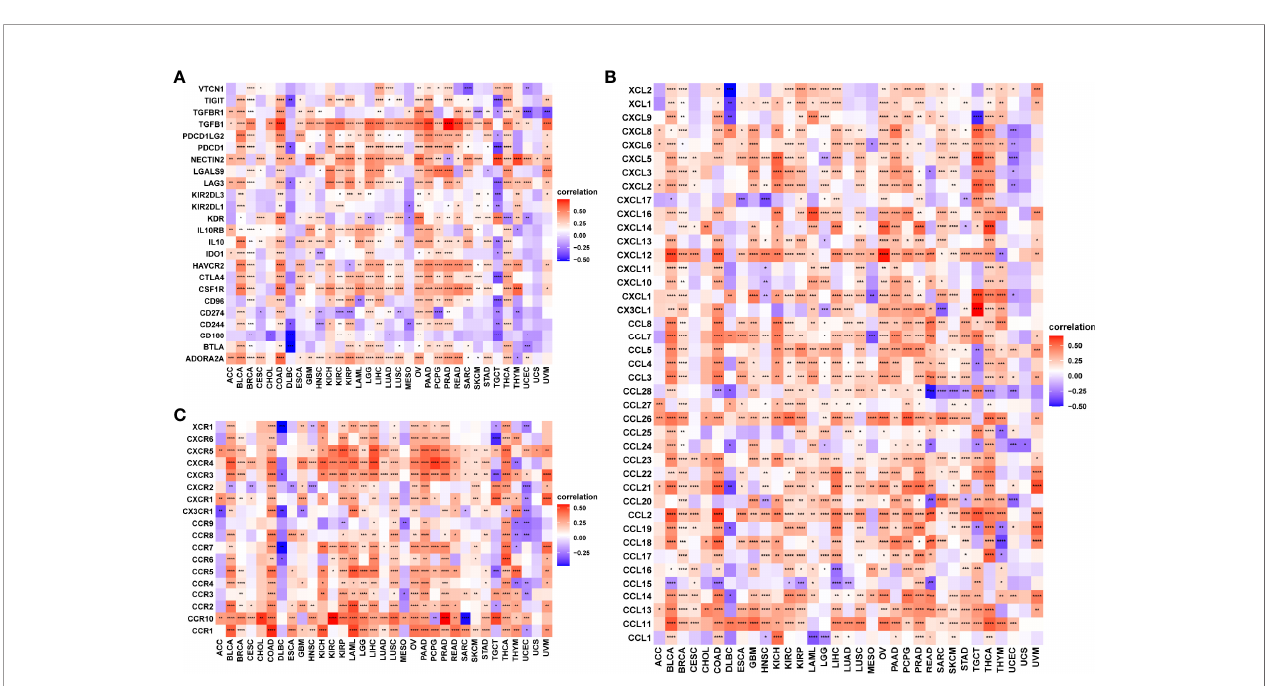
FIGURE 8 | Correlation analysis between RCN3 expression and immuno-related genes. Correlation analysis between RCN3 expression and immunosuppression- related genes (A) , chemokines (B) , and chemokines receptors (C) . *p < 0.05; **p < 0.01; ***p < 0.001; ****p <